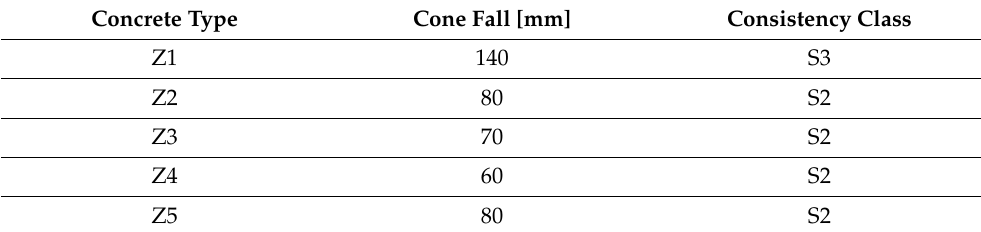
Table 6. Results of the measurement of cone fall.